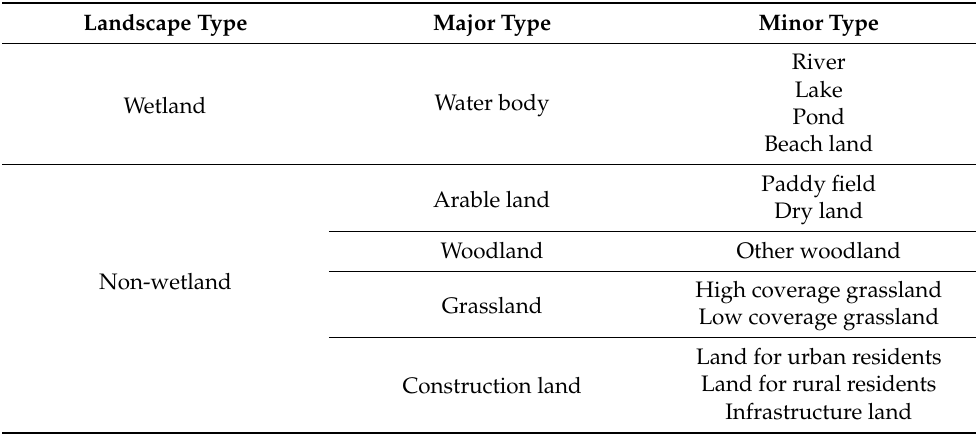
Table 1. Landscape type classification system of the Xiong’an New